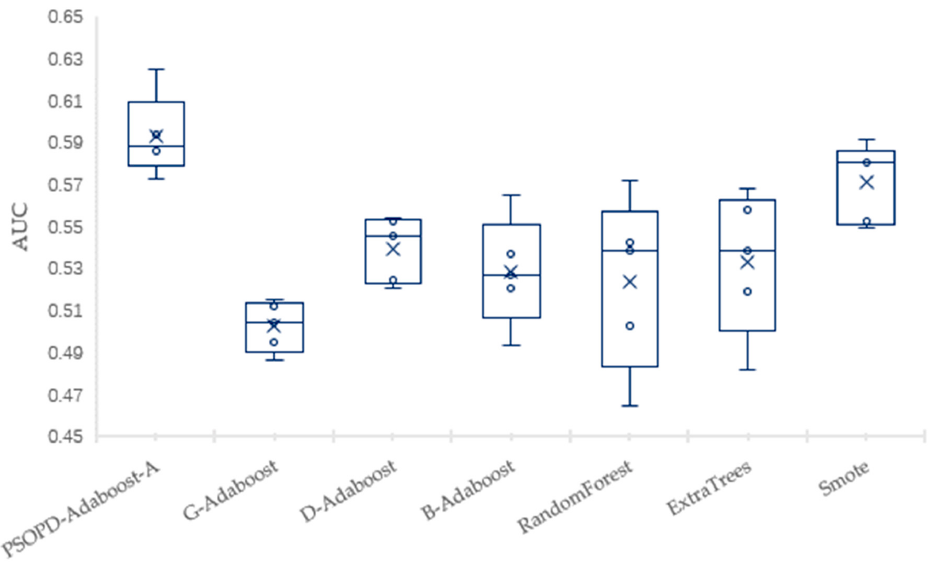
Figure 15. Comparison of AUC on the PC3 Dataset.